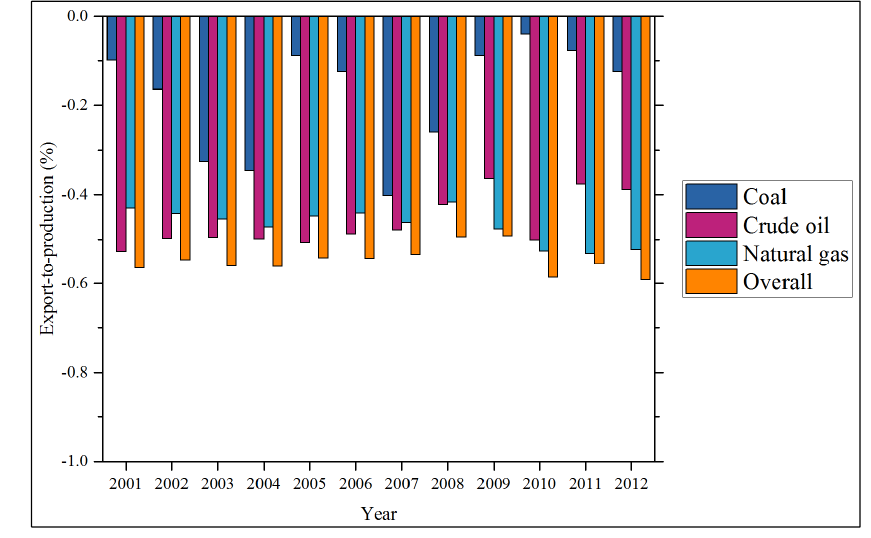
Figure 38. Malaysia: export to production.